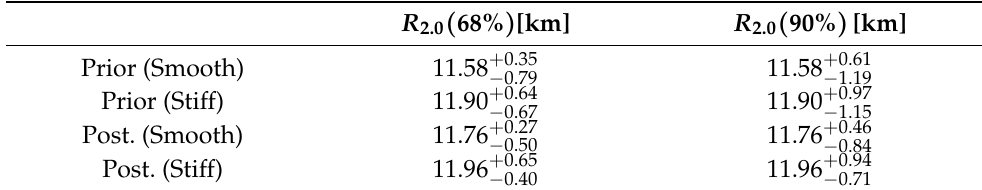
Table 3. The 68% and 90% credibility ranges for R 2.0 associated with the smooth and maximally-stiff high-density priors as well as the two posteriors accounting for all likelihood functions included in this